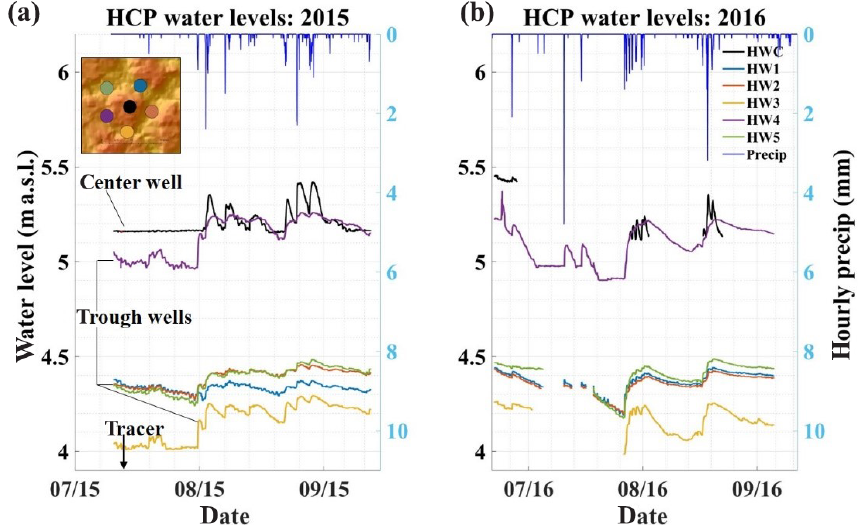
Figure 7. Water levels from the high-centered polygon for the 2015 (a) and 2016 (b) thaw seasons. Dots in the inset (upper-left) correspond to observation-well locations; colors of the dots correspond to well hydrographs. Dark blue lines along the top of the graphs indicate hourly total